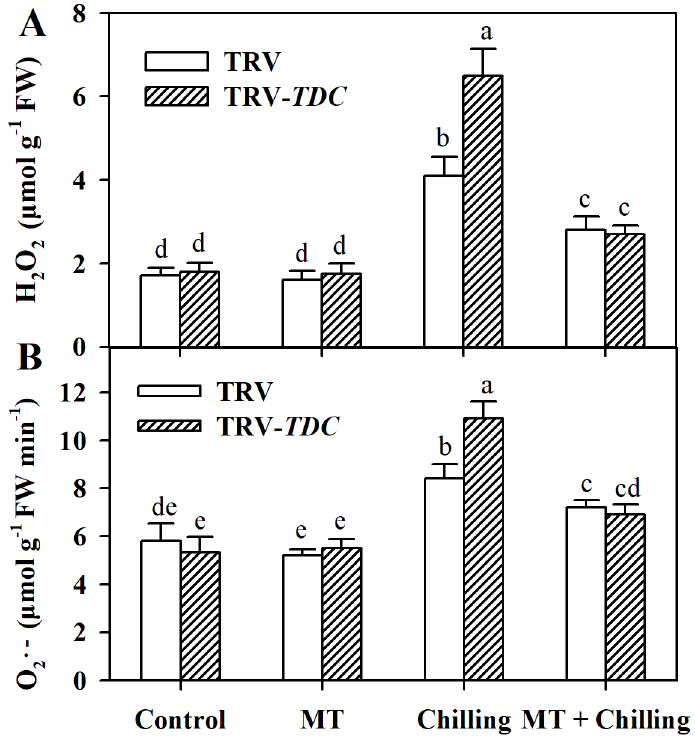
Figure 3. Accumulation of hydrogen peroxide and superoxide anion as affected by TDC silencing and exogenous melatonin in tomato plants under chilling stress. ( A ) H 2 O 2 level; ( B ) O 2 • – level. Tomato plants at the 6-leaf stage were exposed to chilling stress (4 ° C) for 12 h and leaf samples were collected for the determination of reactive oxygen species (ROS) levels. The values presented are means ± SDs ( n = 3). Different letters (a–e) above bars indicate significant difference at p < 0.05 among treatments.